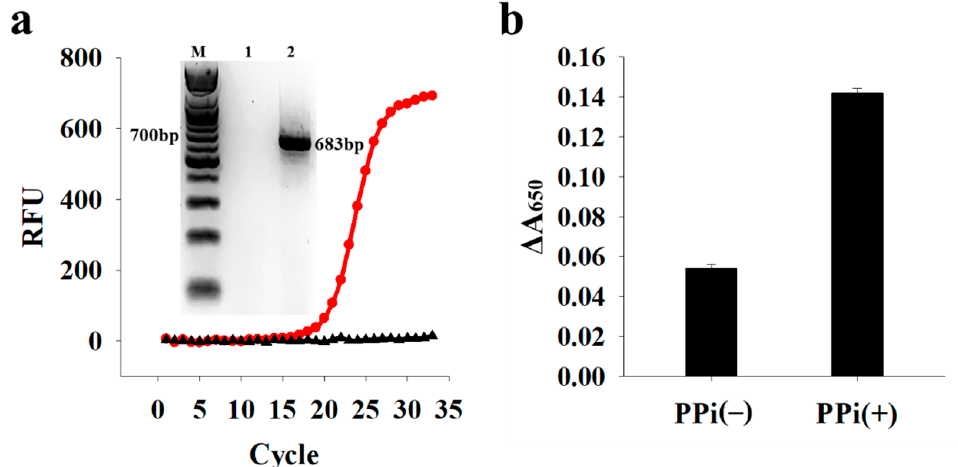
Figure 5. Detection of PCR products from K. pneumoniae. ( a ) PCR amplification curves in the absence (black) and presence (red) of gDNA from K. pneumoniae (1.6 × 10 3 copies/ μ L). Inset shows the corresponding gel electrophoresis results. Lanes 1 and 2 indicate the samples obtained after PCR in the absence and presence of gDNA, respectively. RFU: relative fluorescence unit. ( b ) Δ A 650 in the absence ( − ) and presence (+) of PPi. Change in absorbance signal ( Δ A 650 ) was calculated by subtracting A 650 in the presence of target DNA from that in the absence of target DNA.